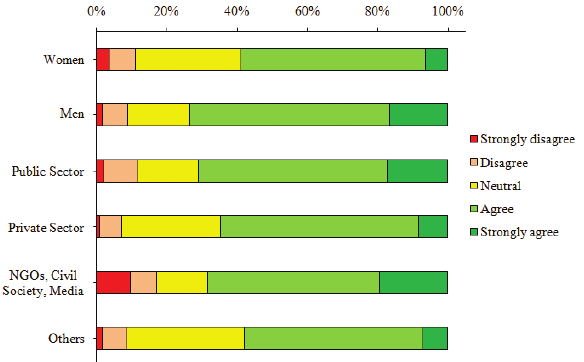
Figure A10. Gender and occupation-wise responses to B4.